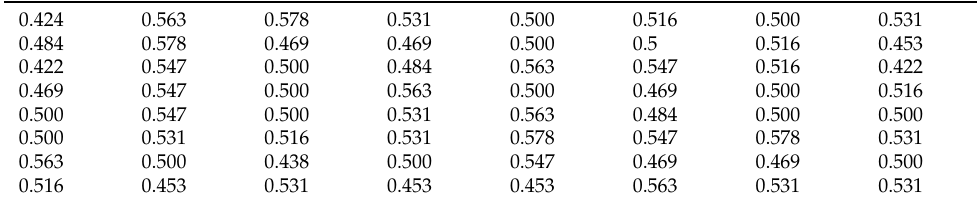
Table 5. Dependence matrix with entries m ij